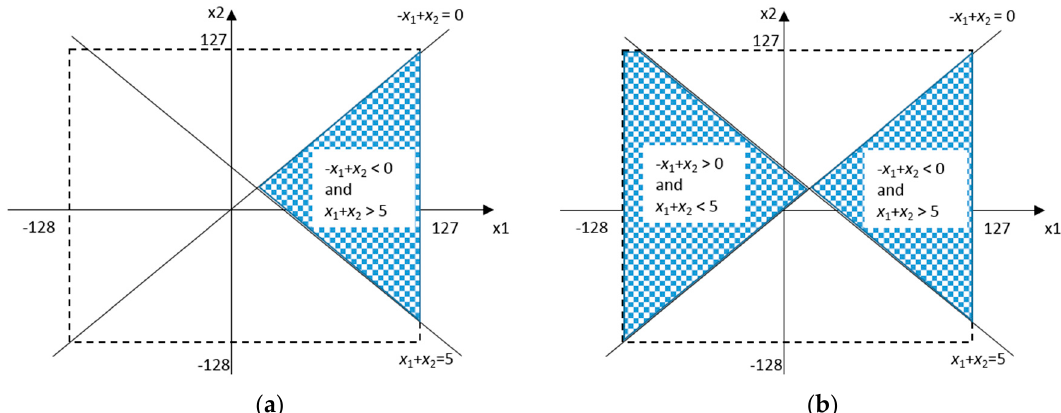
Figure 2. Demonstration of volumes of a convex body and a SMT(LIA) formula: ( a ) Volume of a convex body; ( b ) Volume of a SMT(LIA) formula which implies two convex bodies.